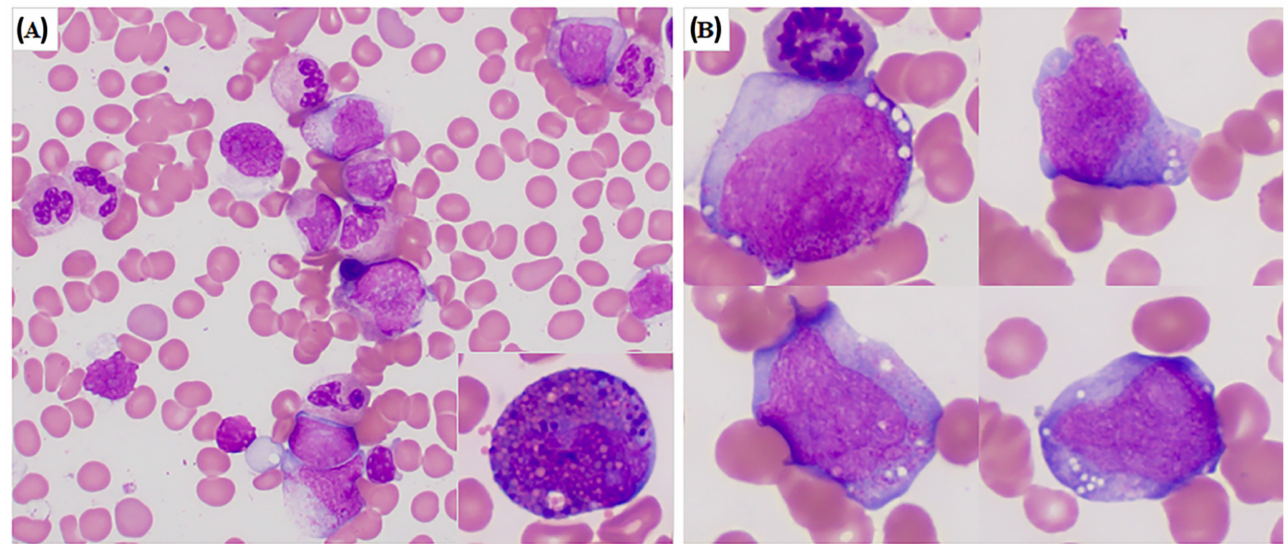
Figure 1. Bone marrow smear morphology of our patient with CBF AML through t(2;16)(q37;q22)/ CBFB::PPP1R7 rearrangement. ( A ). Representative area of bone marrow smears shows blasts, as well as maturing myeloid and monocytic cells. Rare abnormal eosinophils with basophilic granules were present (insert). ( B ). This composite figure illustrates the morphology of blasts. Most of the AML cells were large with round to irregular nuclei, dispersed chromatin, distinct nucleoli, and moderate amounts of basophilic cytoplasm. Some of the AML cells had cytoplasmic granules and